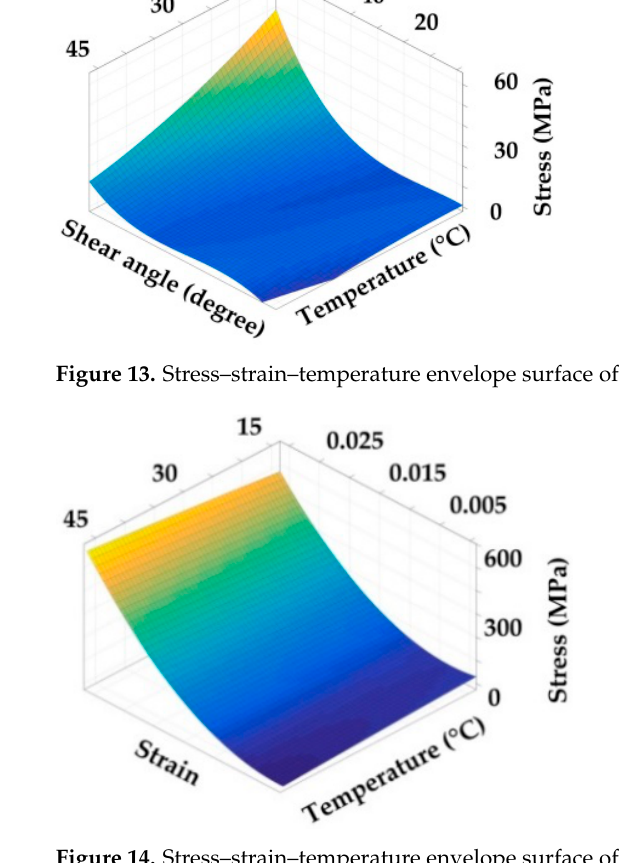
Figure 14. Stress–strain–temperature envelope surface of axial tensile test.